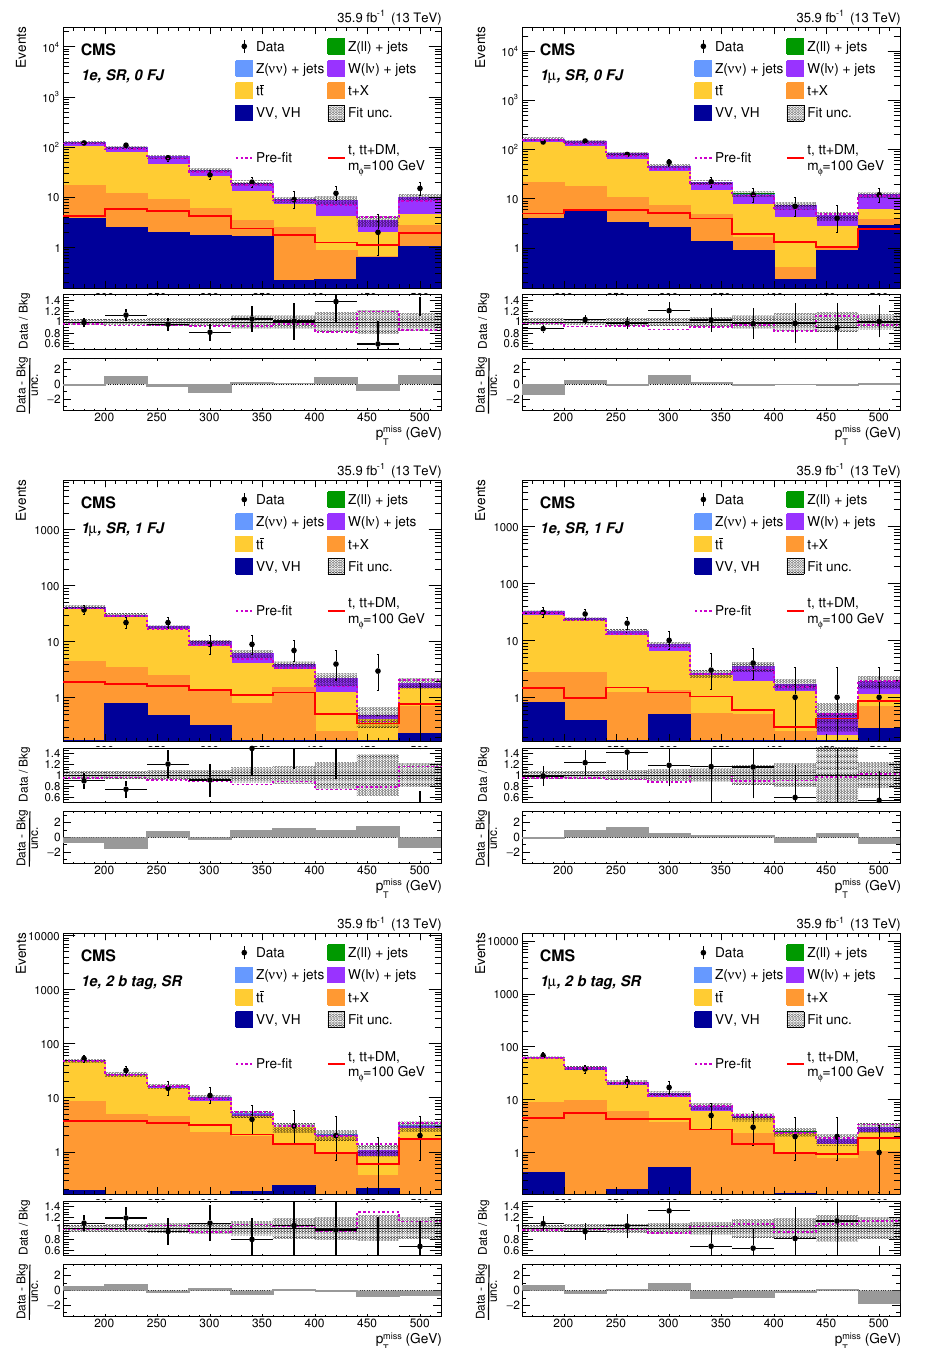
Figure 4 . Background-only post-(cid:12)t p miss distributions for the SRs of the SL selection. The total T theory signal (t = t+DM and tt+DM summed together) is presented by the red solid lines for a scalar mediator mass of 100 GeV. The last bin contains over(cid:13)ow events. The dashed magenta lines show the total pre-(cid:12)t background expectation in the upper panels, and the ratio of pre-(cid:12)t total background to post-(cid:12)t total background in the middle panels. The lower panels show the di(cid:11)erence between observed and post-(cid:12)t total background divided by the full statistical and systematic uncertainties.